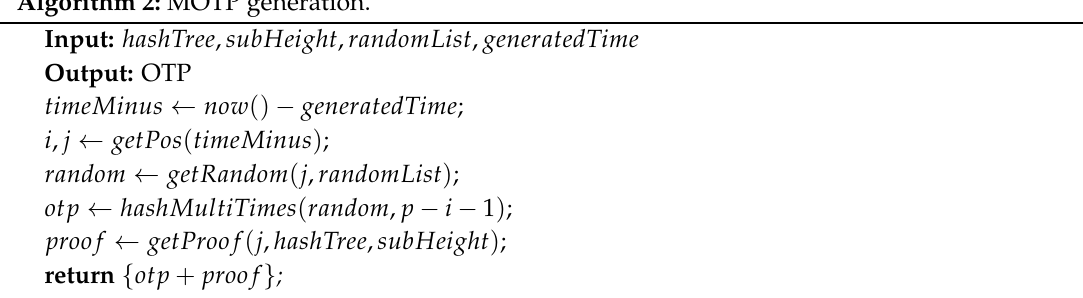
Algorithm 2: MOTP generation.